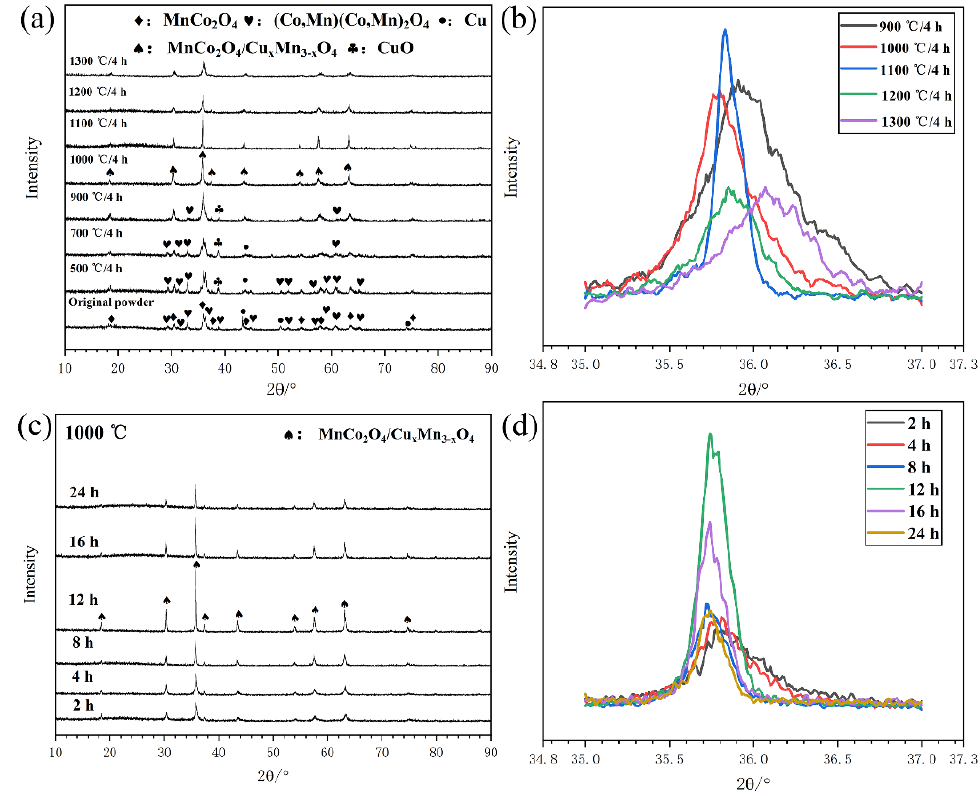
Figure 5. XRD patterns of doped powders sintered under different conditions: ( a ) and ( b ) 500–1300 °C for 4 h; ( c ) and ( d ) 1000 °C for 2–24 h. 4 h; ( c , d ) 1000 ◦ C for 2–24